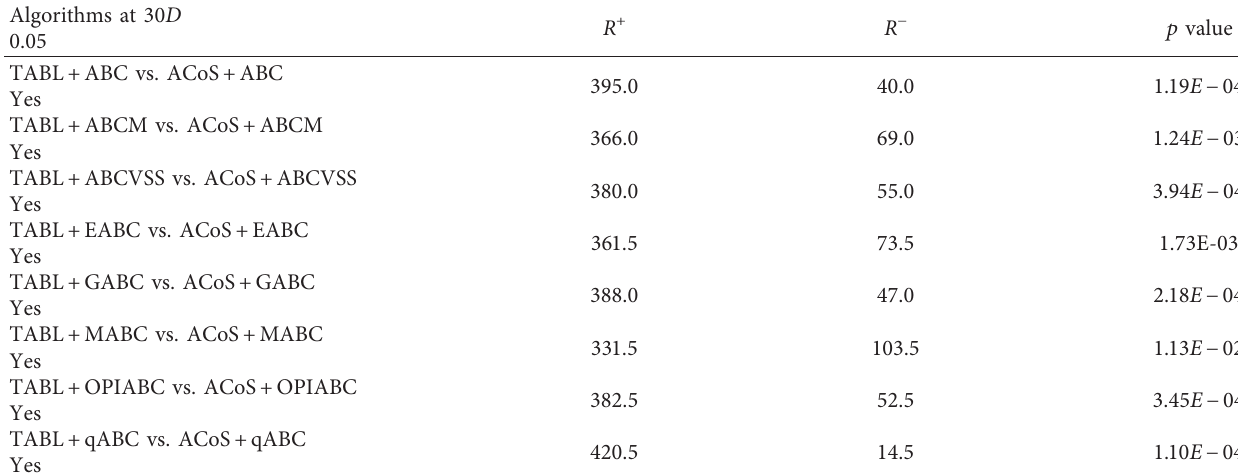
Table 7: The statistical results of the multiple-problem Wilcoxon test for TABL+ABCs vs. ACoS+ABCs. Algorithms at 30